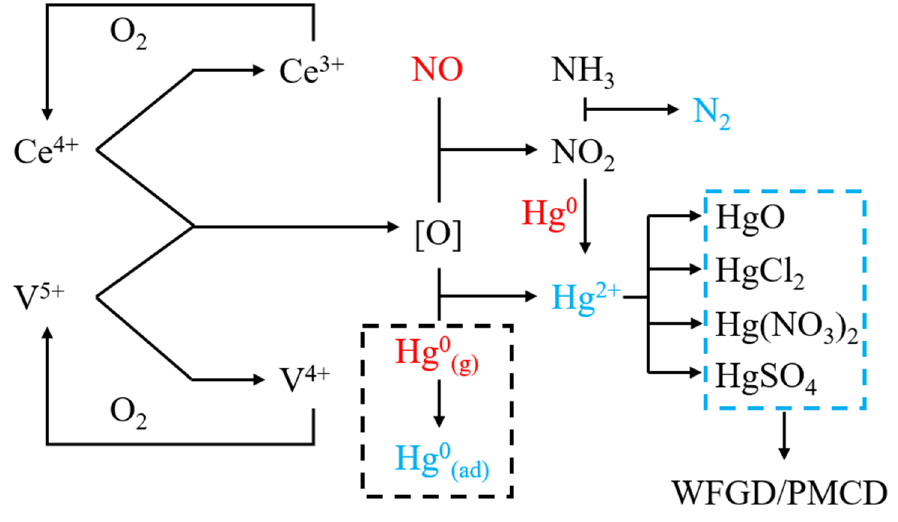
Figure 11. Mechanisms of Hg 0 and NO removal over the catalysts.